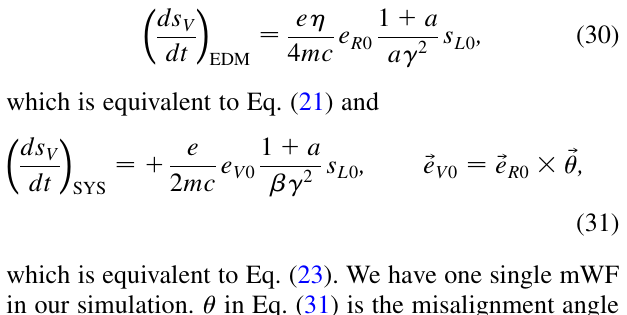
FIG. 4. The vertical spin component, s , normalized to 1, vs V time for the proton, assuming a misalignment angle of 0.1 milli- radian when the magic Wien filter is on. In red, the momentum is 0 : 7 GeV =c , green 1 : 4 GeV =c , blue 2 : 1 GeV =c , and magenta 2 : 8 GeV =c . The EDM-like background signal (systematic error) is the slope of the vertical spin component as a function of